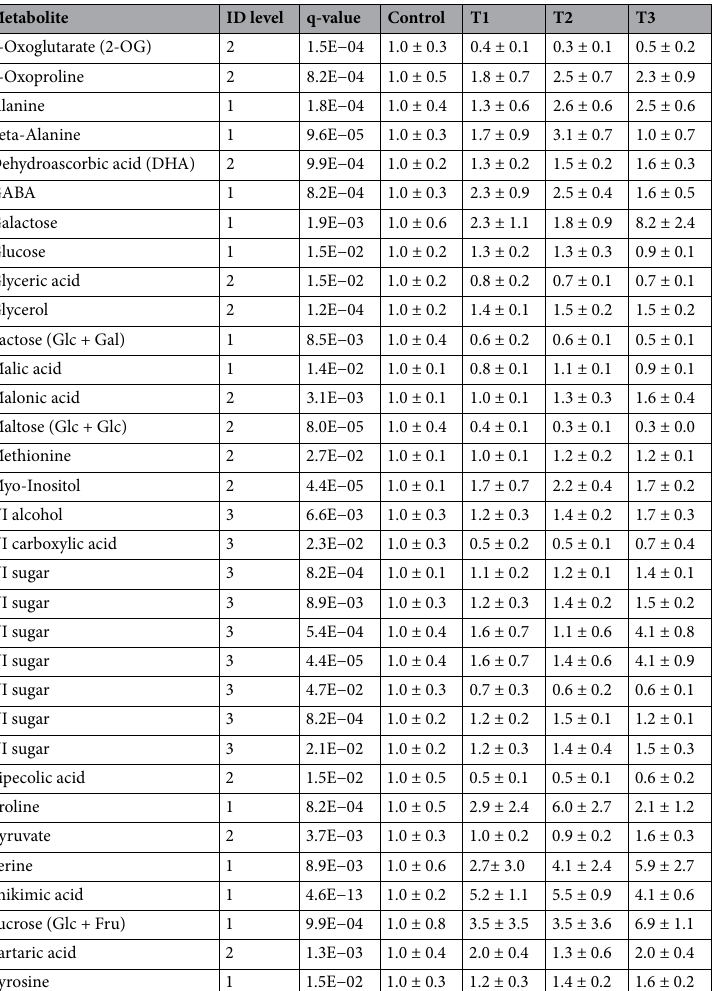
Table 3. Metabolites with significant differences (ANOVA, FDR-adjusted p < 0.05 ) on Experiment 2 (LOMAS). Relative levels in relation to control samples. T1: 4 weeks’ treatment; T2: 3 weeks’ treatment; T3: 2 weeks’ treatment. ID level (1: confirmed with analytical standards; 2: confirmed with retention index and mass spectra from NIST and GMD; 3: non-identified metabolite—functional group prediction according to their mass